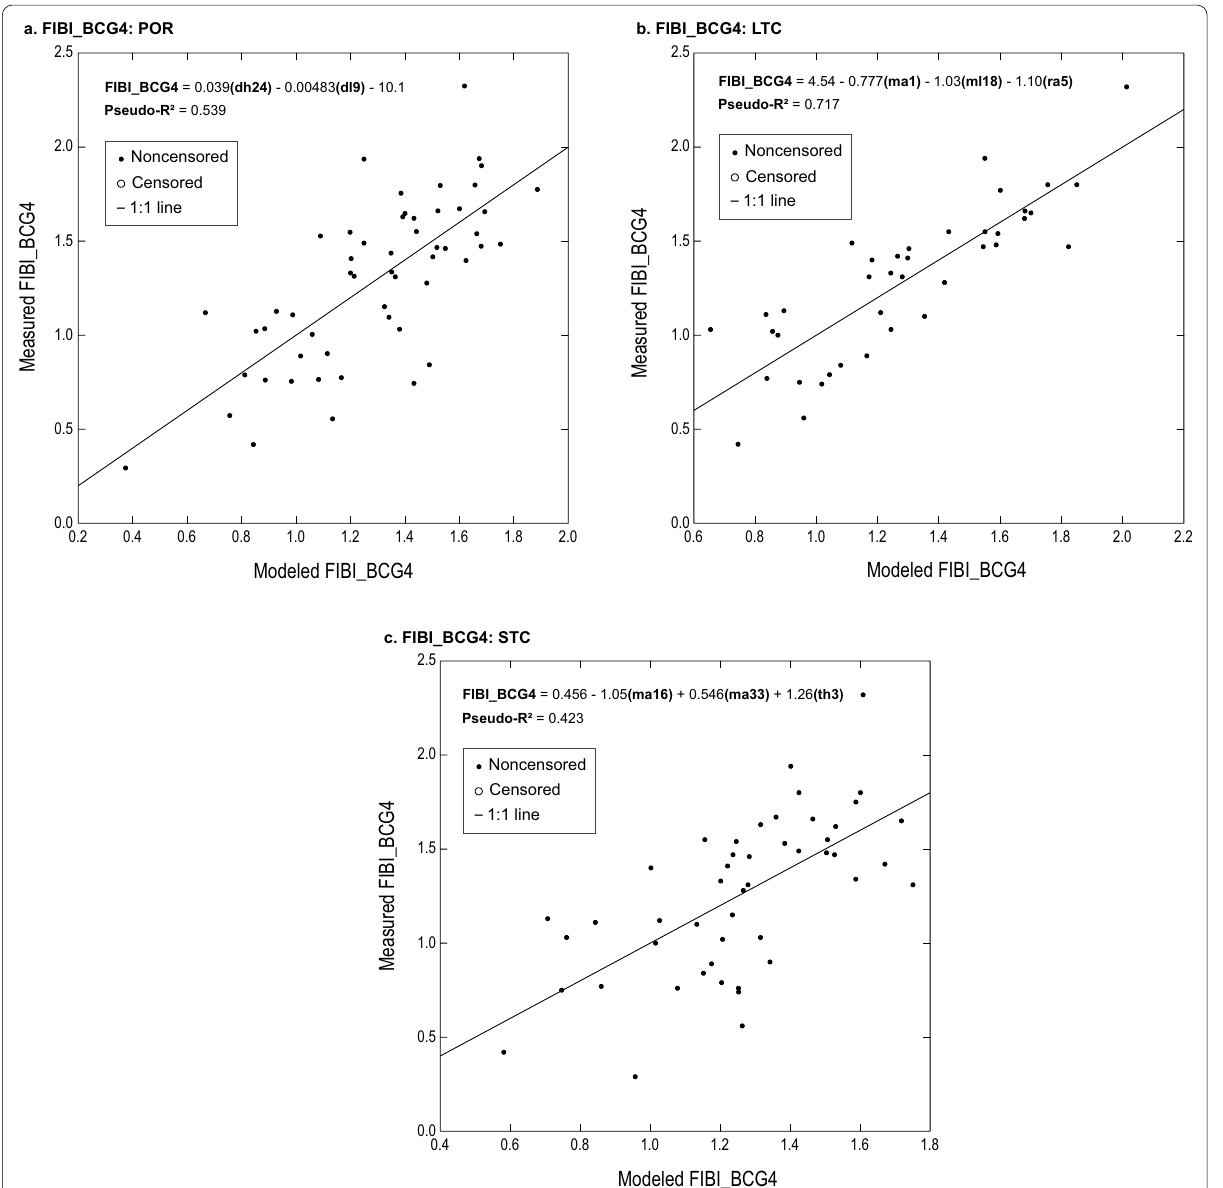
Fig. 6 Measured versus modeled value plots for regression models of fish index of biotic integrity scores normalized to impairment thresholds defined by biological condition gradient 4 (FIBI_BCG4) for stream classes associated with the three hydrologic datasets (Table 5, Krall et al. 2022): a period of record (POR), b long-term change (LTC), and c short-term change